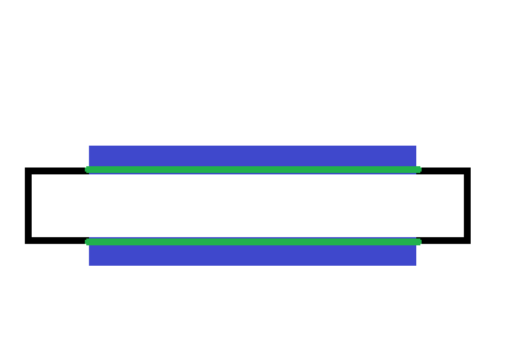
Figure 1. Diamond detector: diamond crystal (white), electrodes (green), conversion layer (blue).